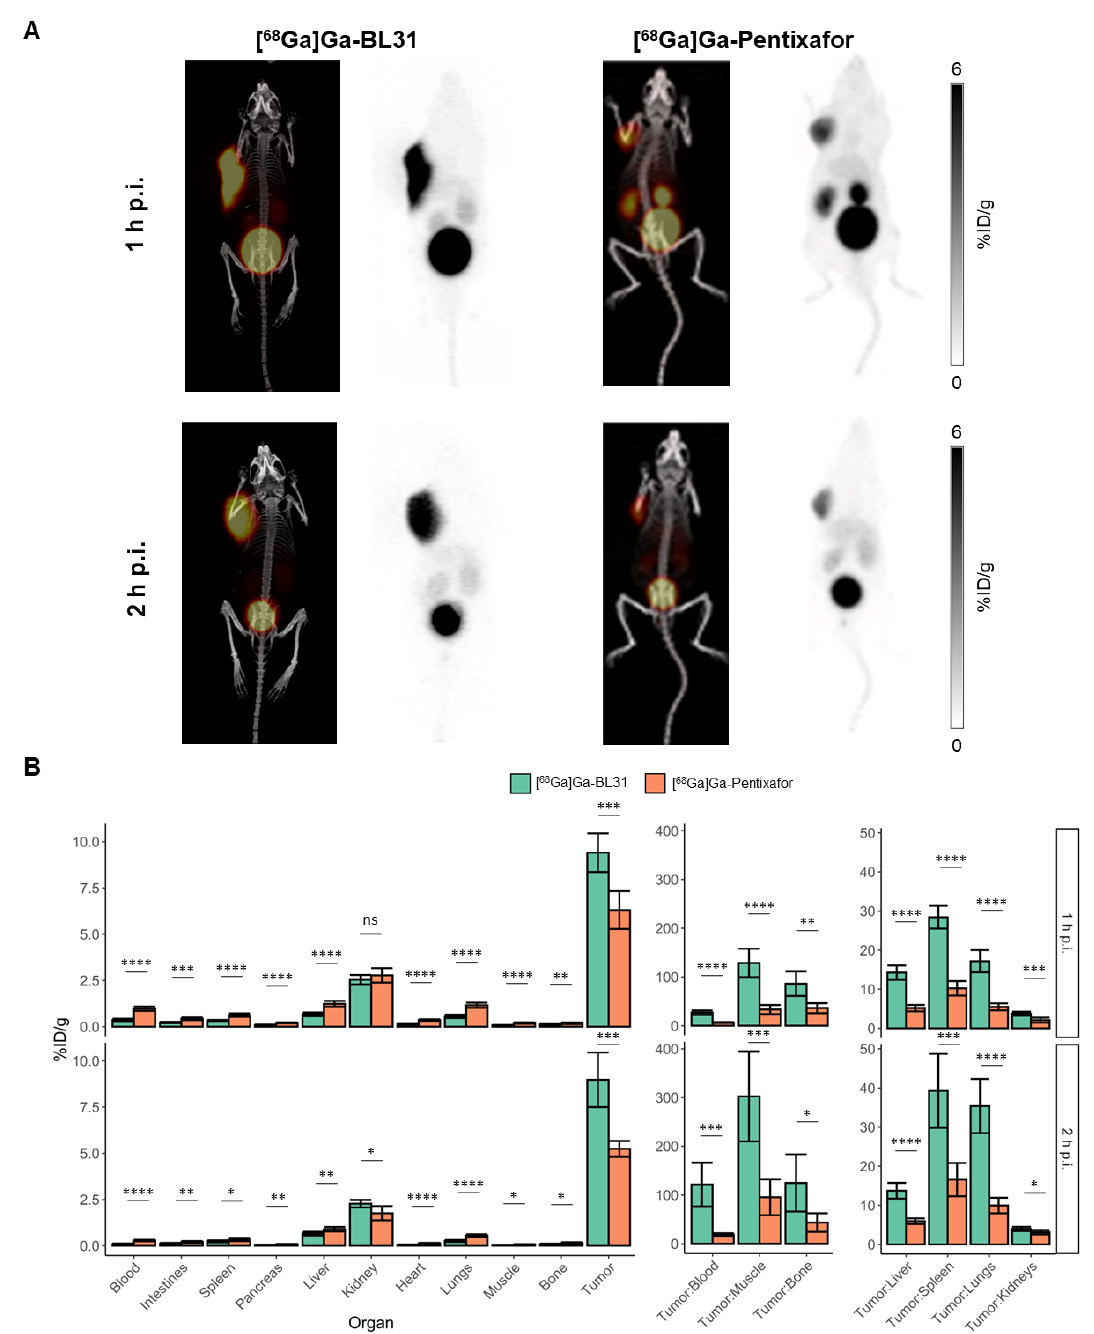
Figure 5. ( A ) Maximum intensity projections for PET/CT and PET alone at 1 and 2 h p.i. of [ 68 Ga]Ga- BL31 and [ 68 Ga]Ga-Pentixafor. Scales of the PET images of [ 68 Ga]Ga-BL31 and [ 68 Ga]Ga-Pentixafor are 0–6 %ID/g. ( B ) Ex vivo biodistribution data of [ 68 Ga]Ga-BL31 in comparison to that of [ 68 Ga]Ga- Pentixafor in Daudi xenograft-bearing mice at 1 and 2 h p.i. ( p < 0.05 = *, p < 0.01 = **, p < 0.001 = ***, p < 0.0001 = ****, ns = not significant).